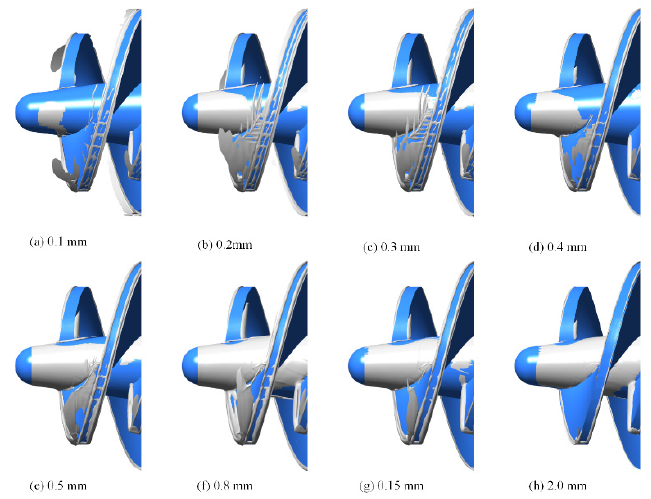
Figure 13. Vorticity Diagram of Inducer Region for Each Clearance.